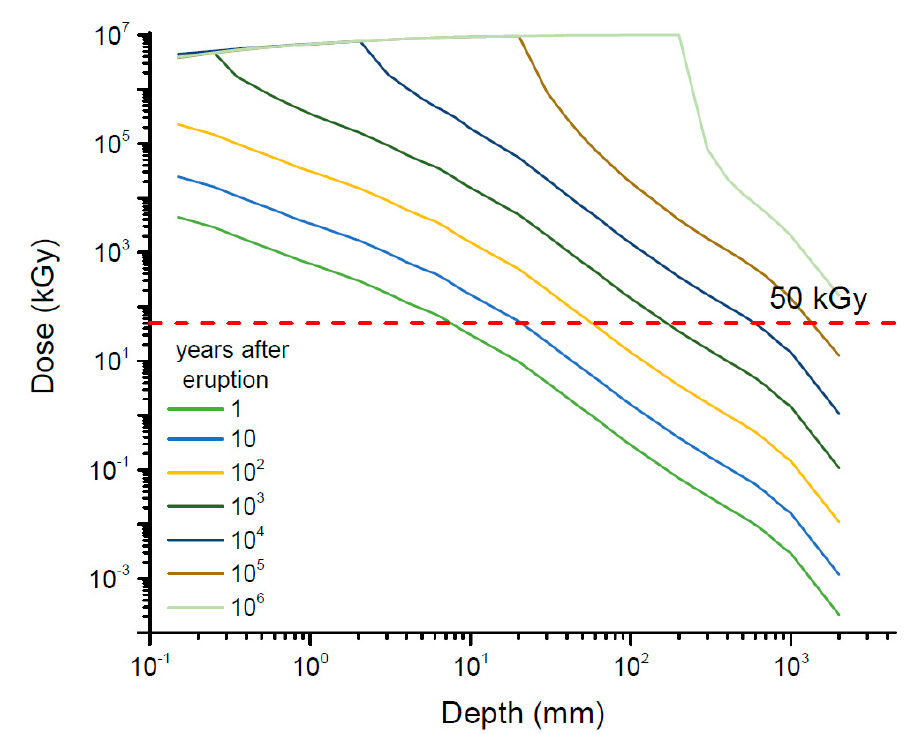
Figure 4. Total dose accumulation rate in dependence on exposure time and “fresh ice” depth. Red dashed line demonstrates the upper limit of the Deinococcus radiodurans VKM B-1422 T survival in our experiment.